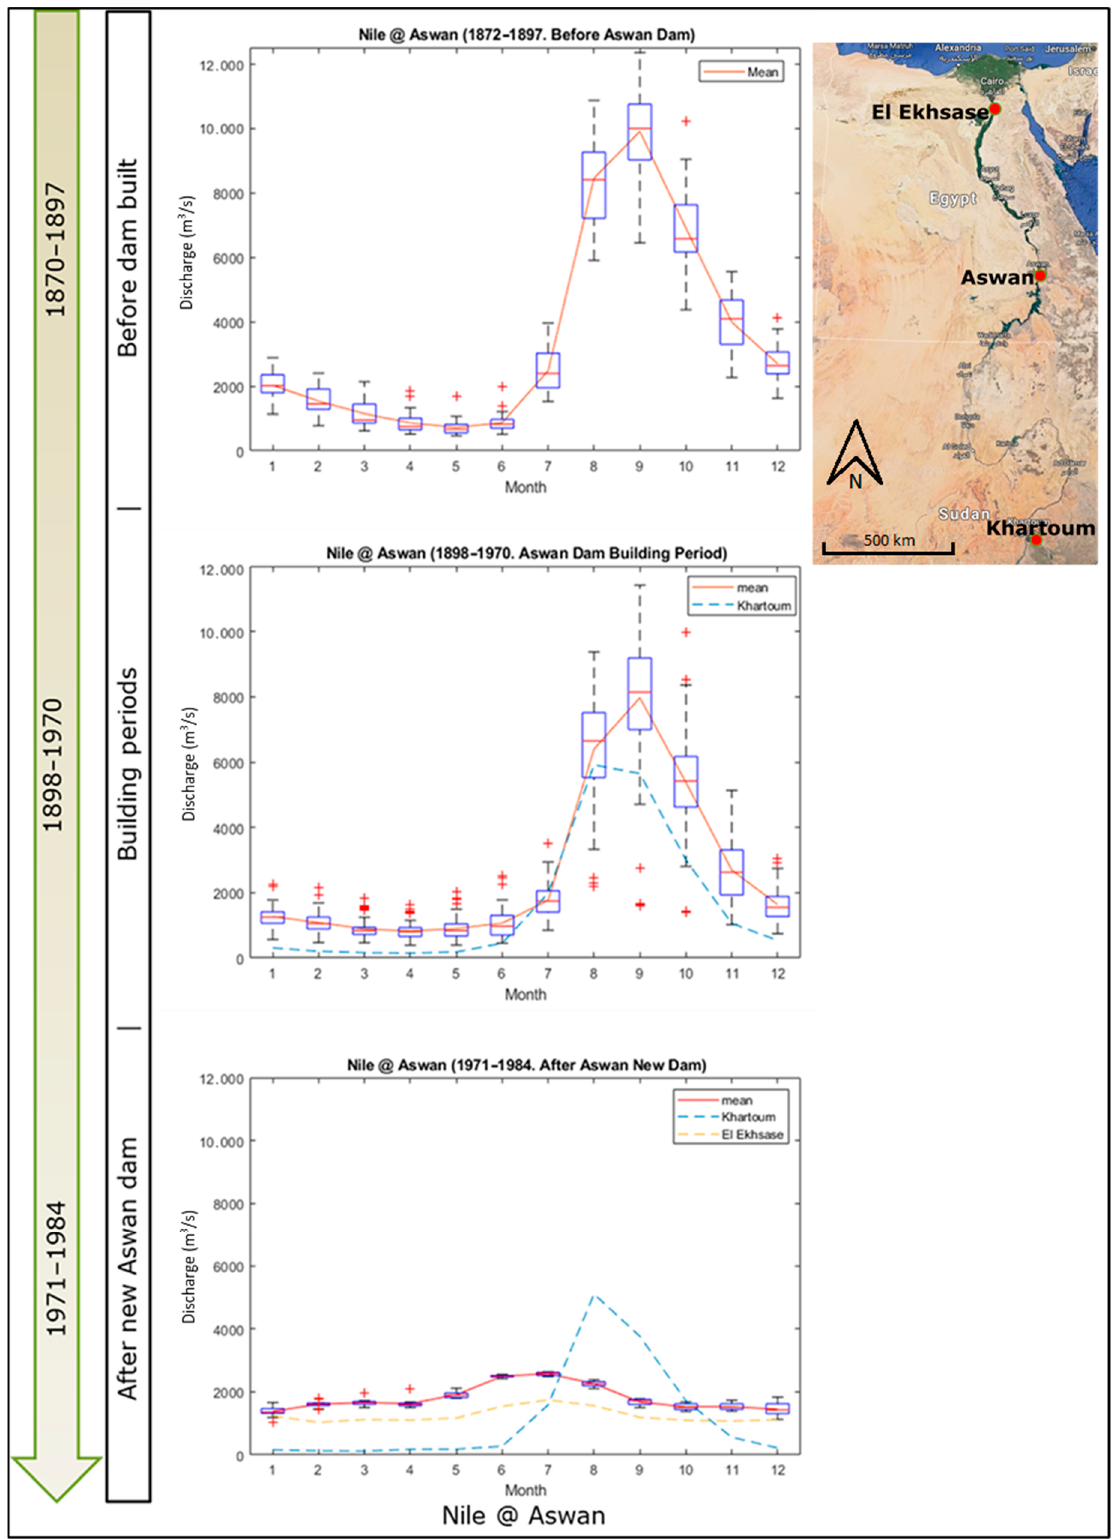
Figure 1. The change of the discharge pattern of the Nile River. Legend: The red ʺ mean ʺ lines in three discharge figures show the mean discharge rate of the Nile River at the downstream side of the Aswan dam; the blue lines are the mean discharge rate at Khartoum; the yellow line is the mean discharge rate at El Ekhsase. People with relatively lower socioeconomic status often have a limited choice and would end up living in high flood risk areas such as riverbanks and coastlines,